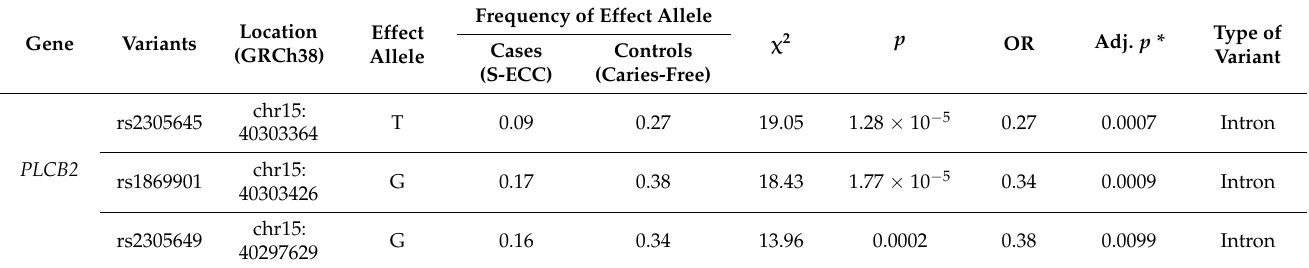
Table 1. Allelic association of genetic variants with severe early childhood caries (S-ECC).